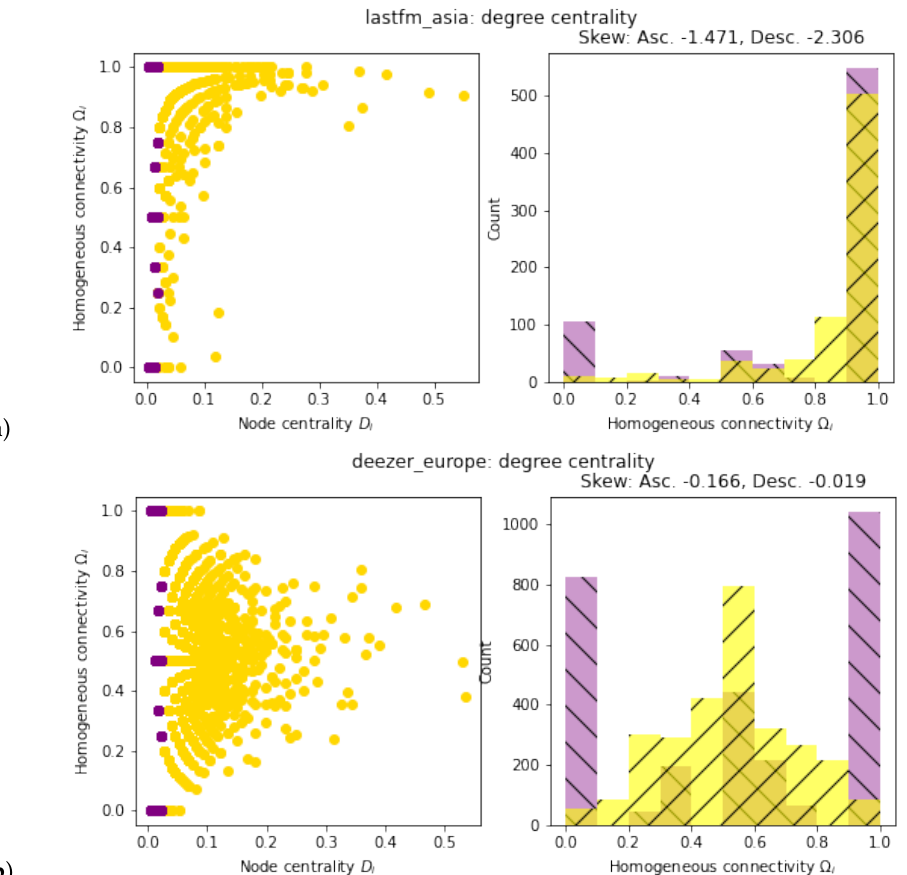
Figure 6. The left figure here presents scatter plots of node degree centrality D i against node homogeneous connectivity Ω i on the training data. The upper half of nodes according to their centrality are colored in yellow while the lower half is presented in purple. The histogram on the right visualizes the distribution of homogeneous connections. The skew for each subset’s distribution is annotated above the right graph. ( a ) LastFm; ( b )